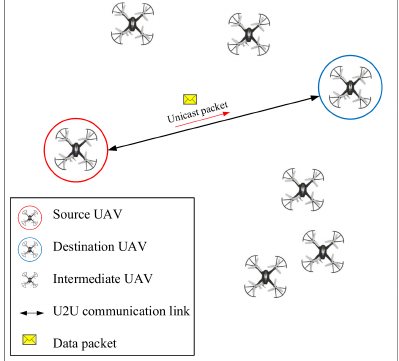
Figure 22. Unicast-based